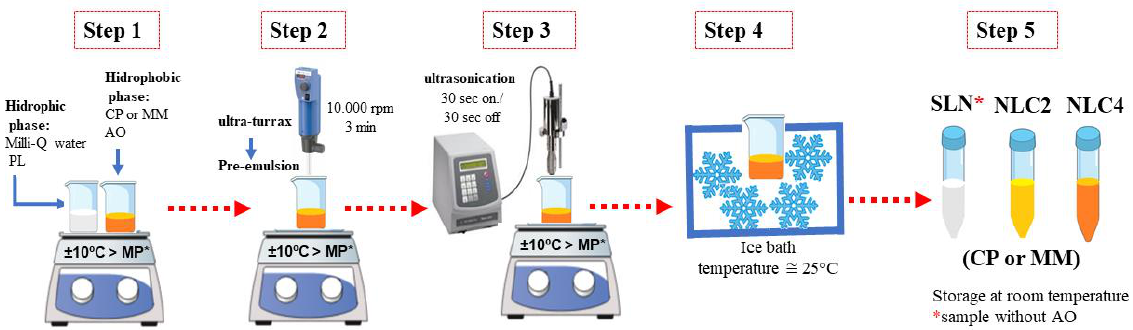
Figure 1. Schematic representation of the method used to prepare lipids nanoparticles (SLN and NLC).